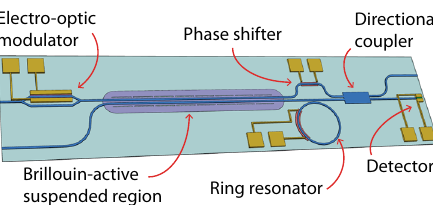
Fig. 5 Fully integrated microwave-photonic notch fi lter. Schematic illustration of an integrated PPER-based notch fi lter, including an electro- optic modulator, a Brillouin-active suspended region (PPER device), and a detector. Other integrated components can include ring resonators, phase shifters, and directional couplers. In this example, the ‘ emit' waveguide (upper waveguide in the Brillouin-active region) serves as the upper arm of the interferometer in Fig. 1 (see Supplement,